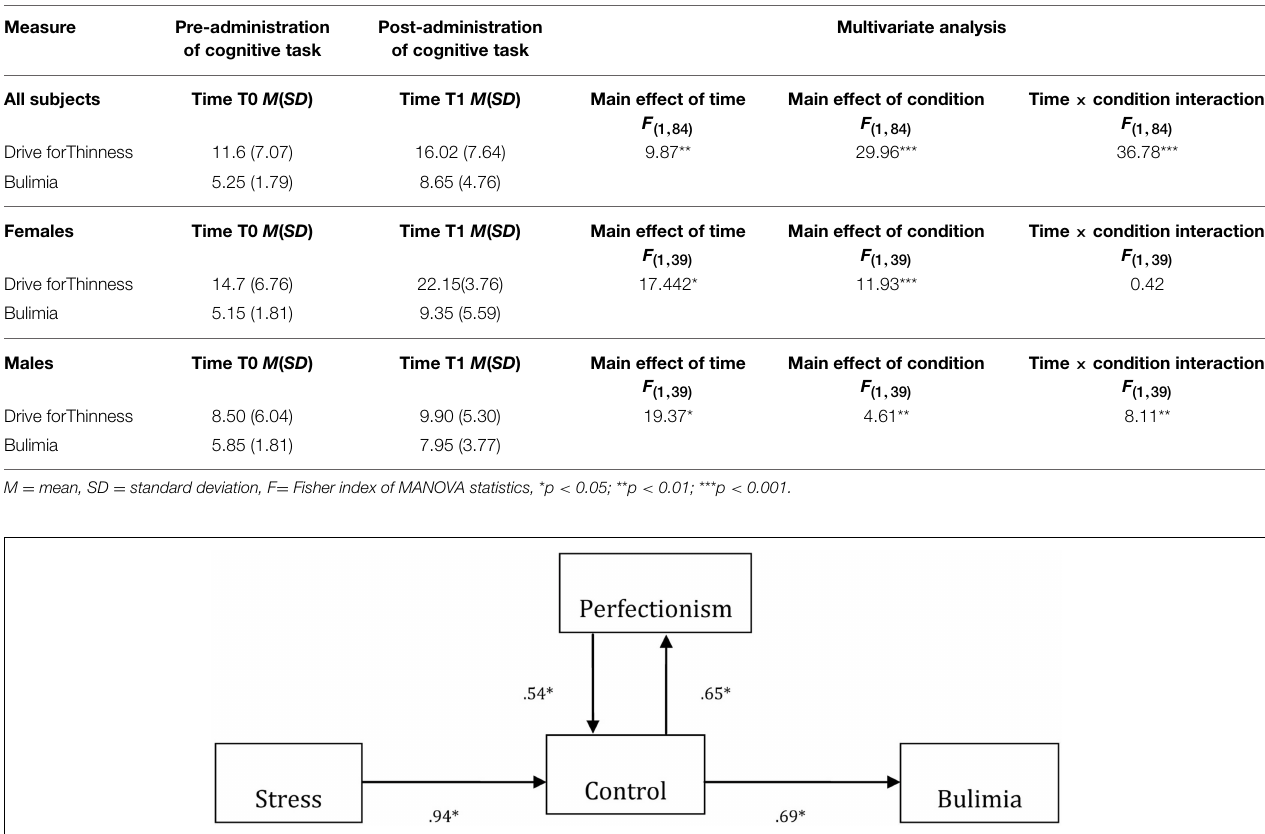
TABLE 1 | Descriptive statistics and between group comparisons on outcome measures at pre- and post-administration tests.